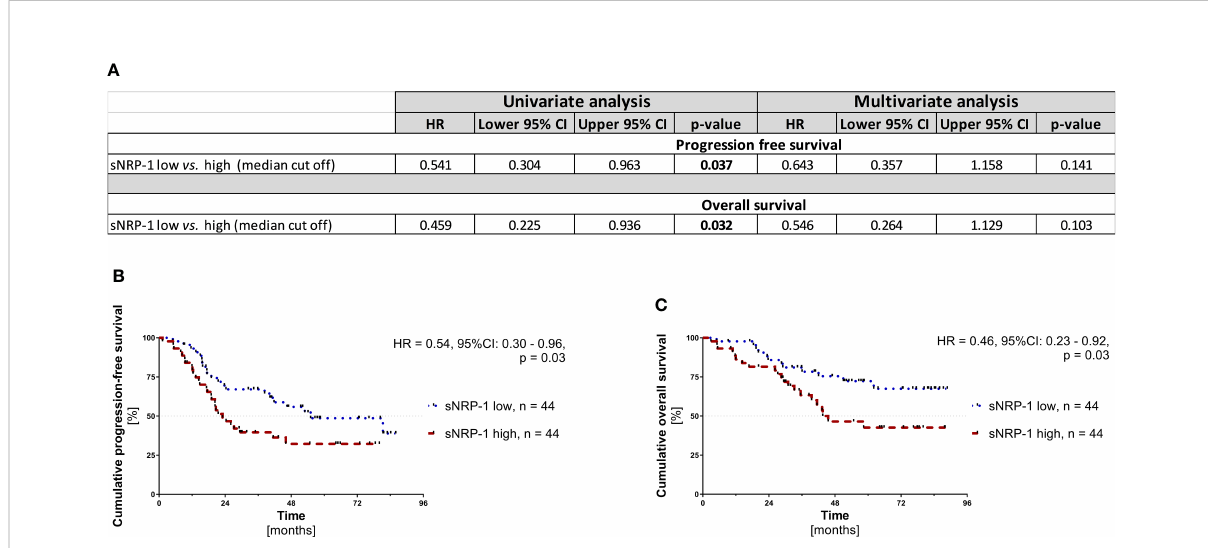
FIGURE 3 Prognostic relevance of sNRP-1. (A) Results from univariate and multivariate Cox proportional hazard regression model analyses of sNRP-1 low (n = 44) vs . sNRP-1 high (n = 44) are shown, including hazard ratio (HR) and 95%CIs and p-values. Kaplan-Meier analyses comparing (B) cumulative progression-free survival (PFS) and (C) cumulative overall survival (OS) of patients with ovarian cancer strati fi ed as above. HR and 95%CI determined by Mantel Haenszel and p-value by log-rank (Mantel-Cox), as described in the methods